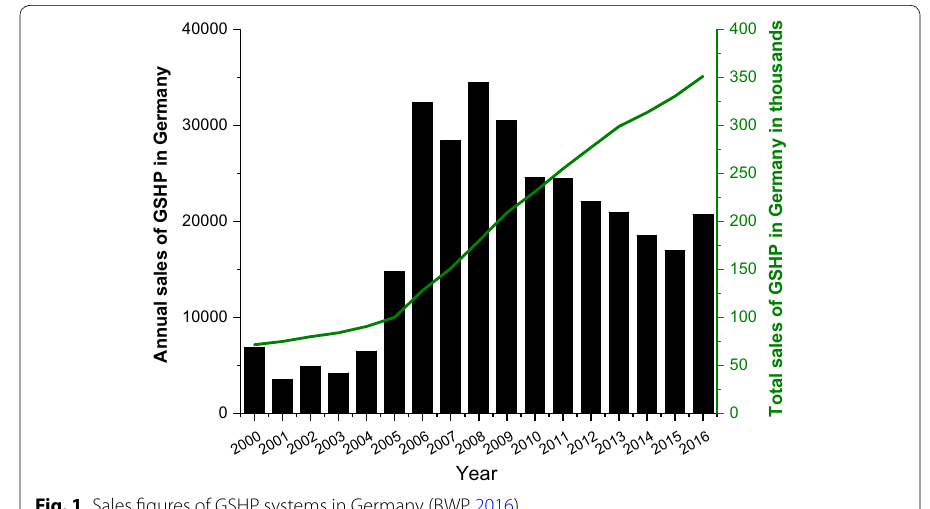
Fig. 1 Sales figures of GSHP systems in Germany (BWP